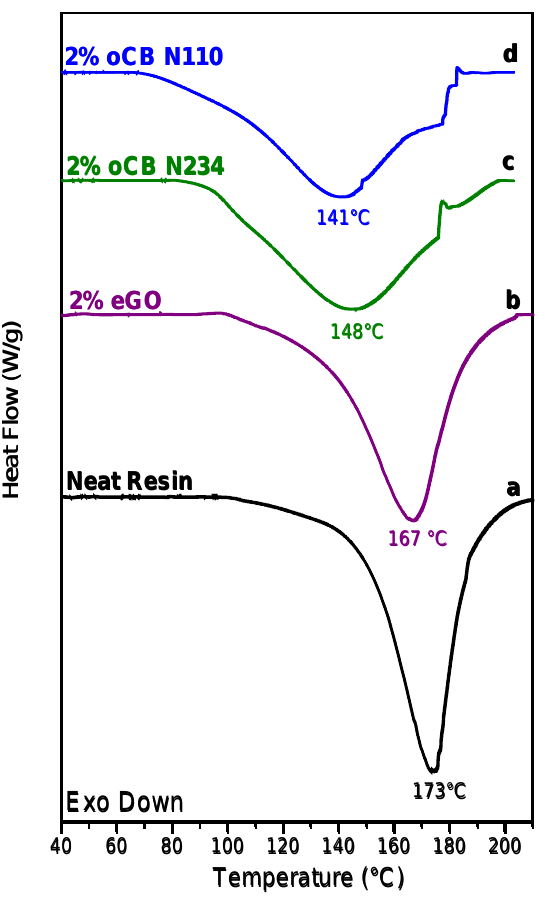
Figure 4. DSC scans at a heating rate of 10 ◦ C / min for resorcinol / HMMM resins (for the weight ratio 1): ( a ) without filler; ( b – d ) with 2 wt % of carbon filler: ( b ) eGO; ( c ) oCB-N234; and ( d ) oCB-N110.